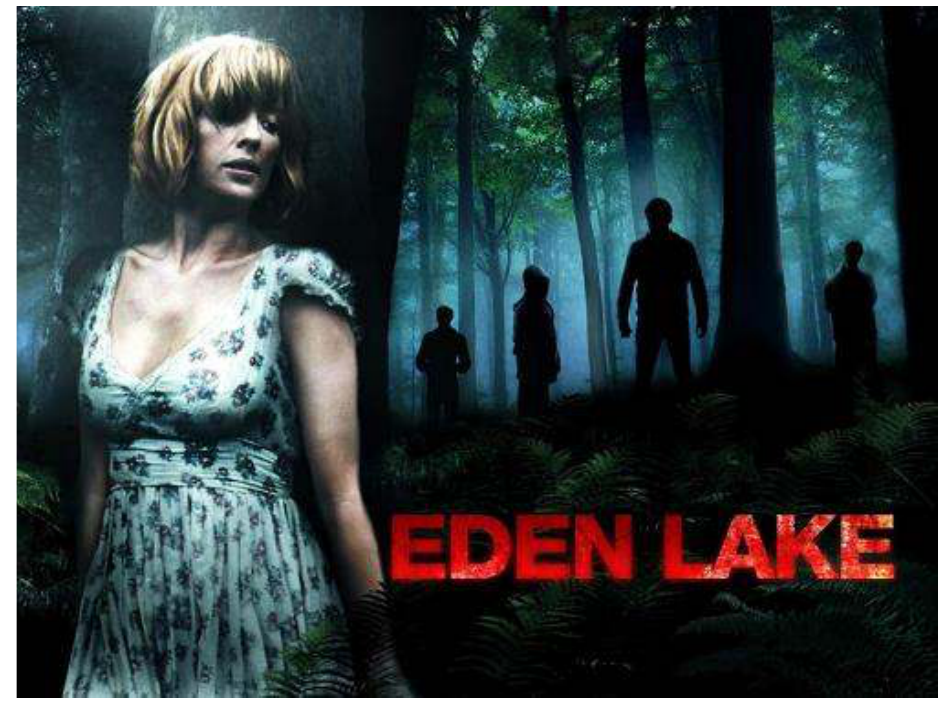
Figure 7. Middle England’s